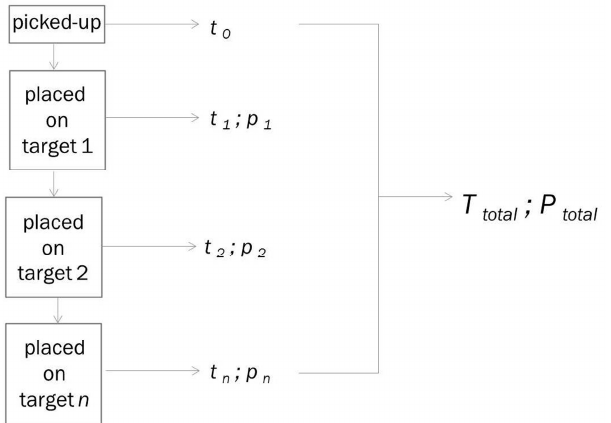
Figure 3. System flowchart of a single trial of the image guided pick-and-place task with n successive critical “place object” steps. The system starts counting task execution time from the moment the object is picked up by the user with the surgical tool ( t 0 ). Ongoing time can be communicated to the trainee at any moment ( t n ) from then, together with the precision score (p n ), which is expressed here in terms of a “pixels-off-target score”. The larger the precision measure P as defined, the lesser the trainee’s precision.